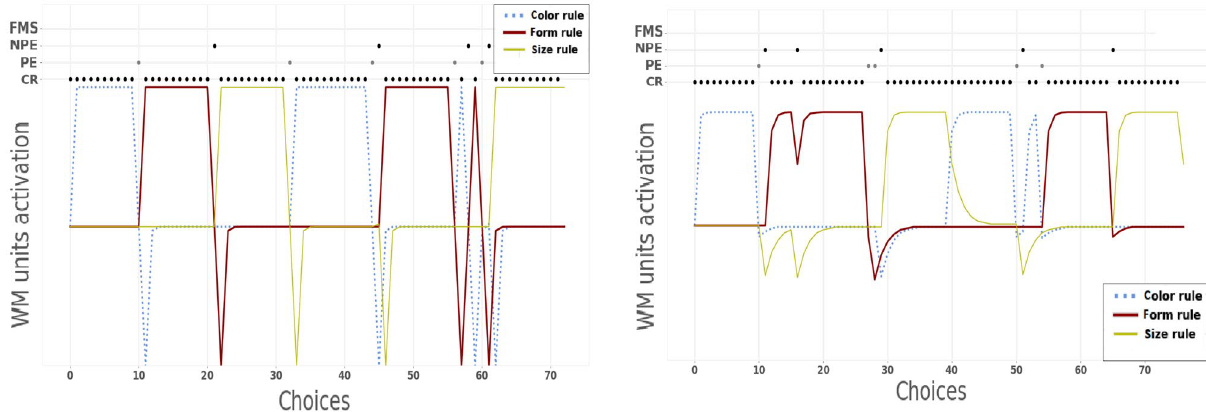
Figure 4. Internal functioning of two control models. Left: model with language. Right: model without language. Each line in the graphs shows the activation of a working-memory unit representing a tendency to choose a specific sorting rule between the three possible rules. The dots at the top of graphs indicate single instances of correct responses (CR) or errors (PE, NPE,